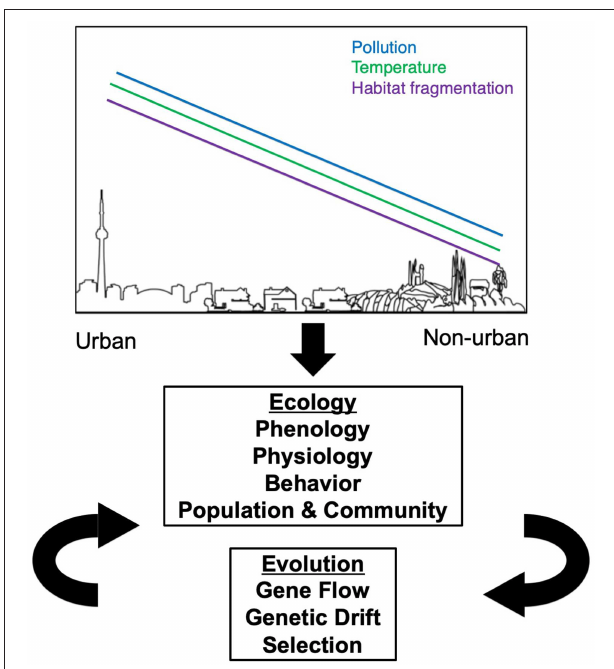
FIGURE 1 | Expected effects of urban environments on the ecology and evolution of herbivorous arthropods. Moving from non-urban to urban landscapes, there is an overall increase in the amount of pollution, temperature, and habitat fragmentation. Each of these three factors influence changes in the ecology of herbivorous arthropods, which in turn can influence their evolution in a feedback